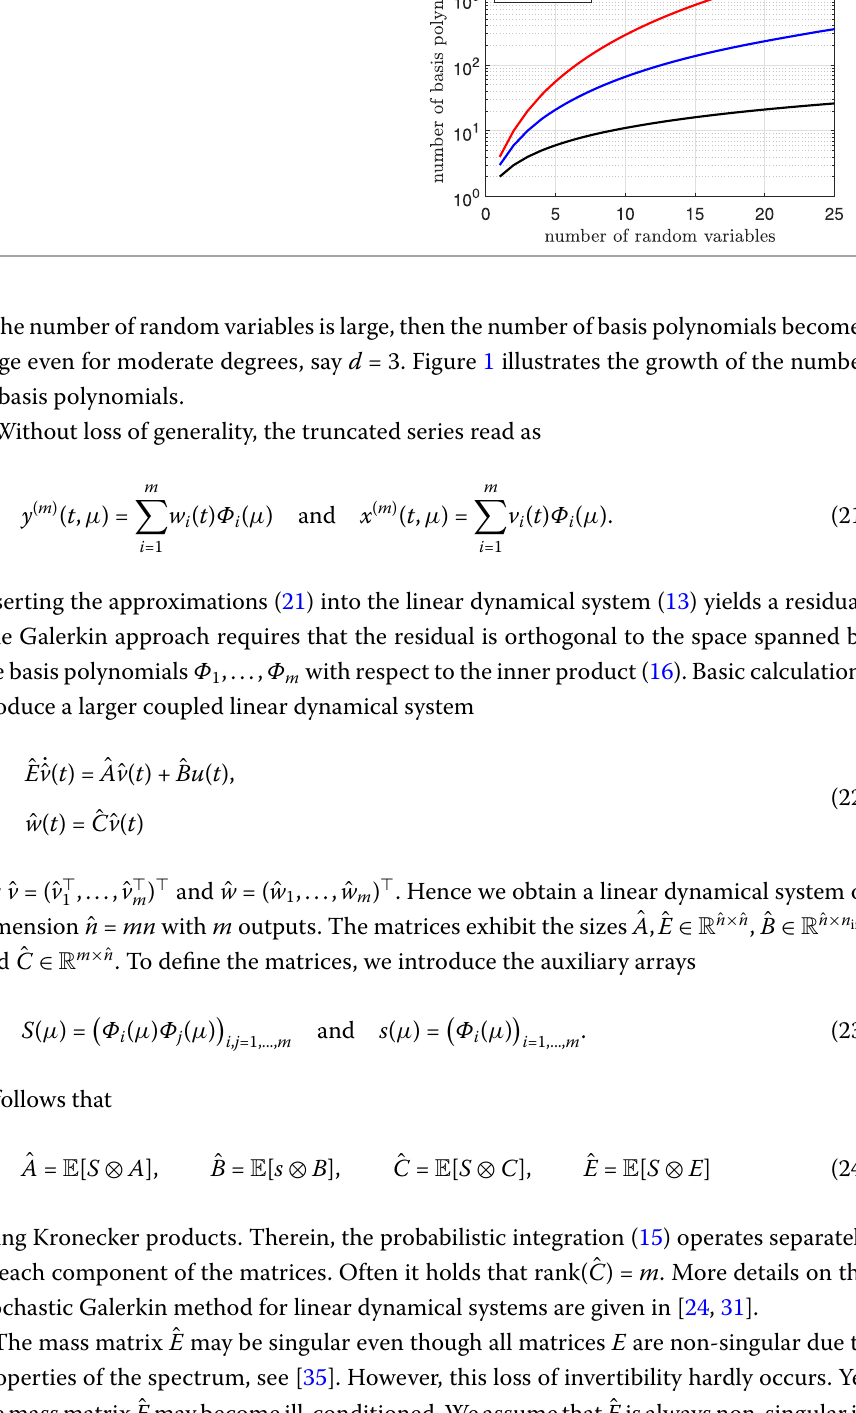
Figure 1 Number of basis polynomials in dependence on number of random variables and total polynomial degree in semi-logarithmic